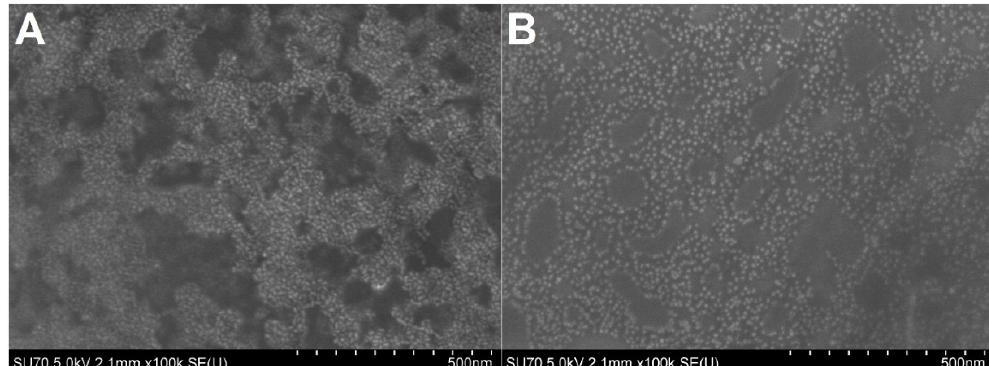
Figure 1. SPR study of CD44 immobilization in both channels of the MUA-modified SPR sensor